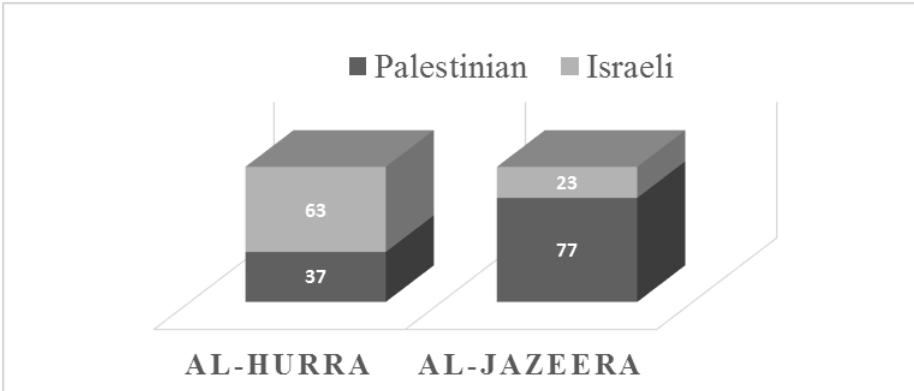
Figure 4. Percentage of excerpts from the Palestinian vis-a-vis the Israeli sources in the news.